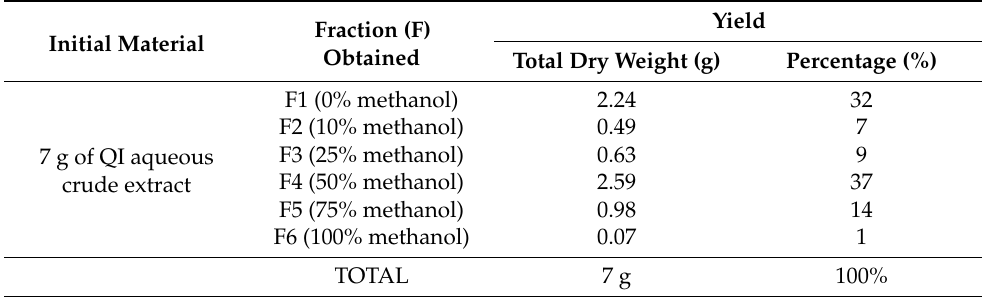
Table 1. Fractions obtained from QI aqueous crude extract and the total dry weight and yield percentage for each